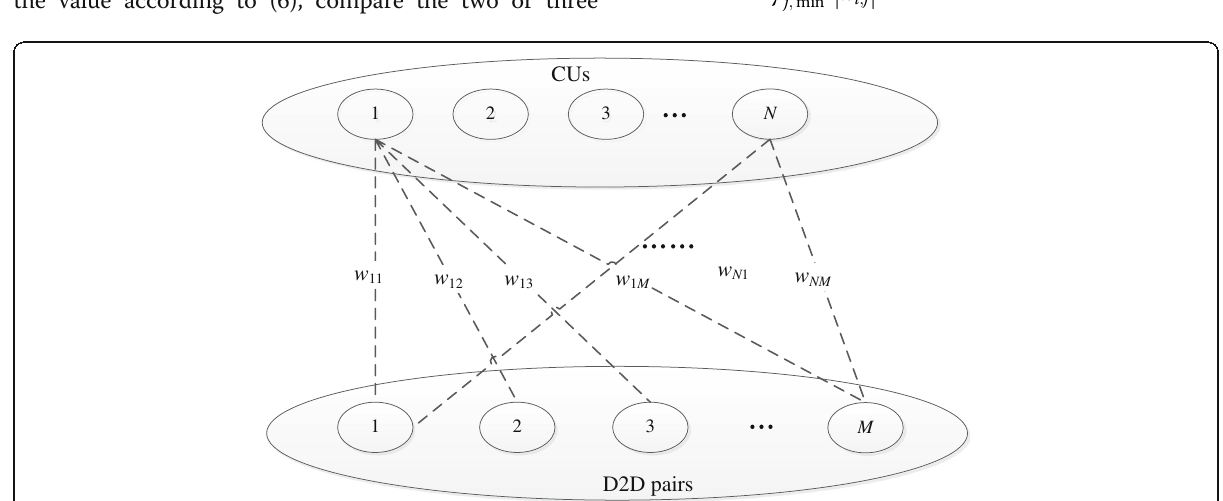
Fig. 3 Bipartite graph for CU and D2D pair